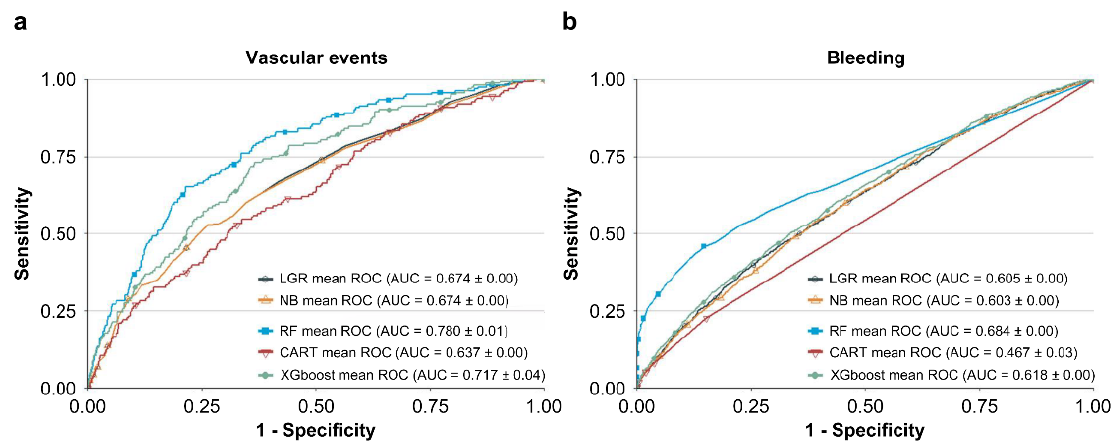
Figure 2. Receiver operating characteristic (ROC) curves of the five methods in predicting ( a ) vascular events and ( b ) bleeding. Table 5. Importance ranking of risk factors in predicting vascular events based on RF and XGBoost. Average Ranking Risk Factors of 10 Times RF